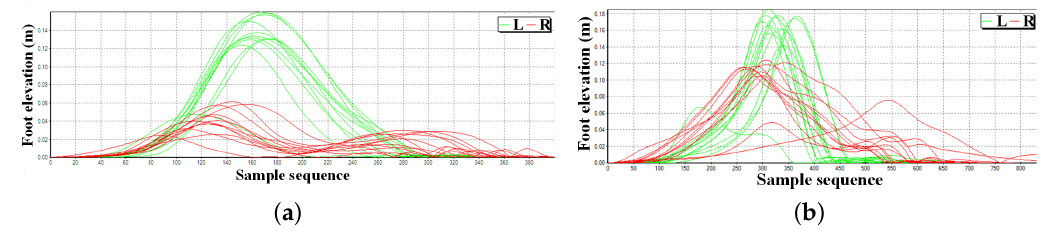
Figure 8. Gait clearance comparison ( a ) a stroke patient; ( b ) an arthropathy patient.